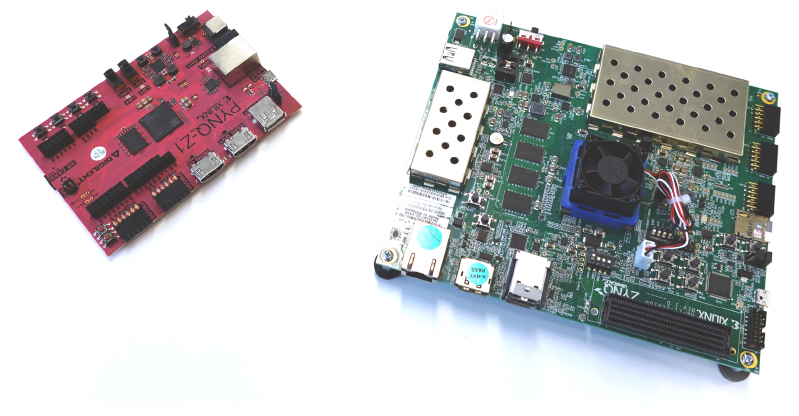
Figure 6. The two deployed evaluation boards: on the left PYNQ-Z1 [24] and on the right Zynq UltraScale+ ZCU104 [21].